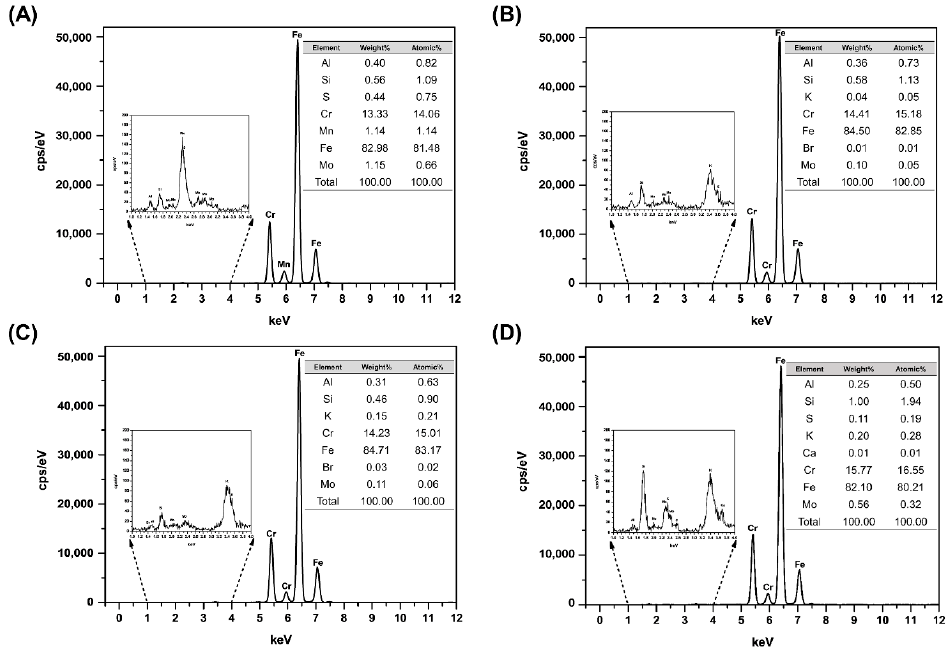
Figure 5. XRF spectra of the ( A ) EM ( B ) AM ( C ) DM and ( D ) OM groups.